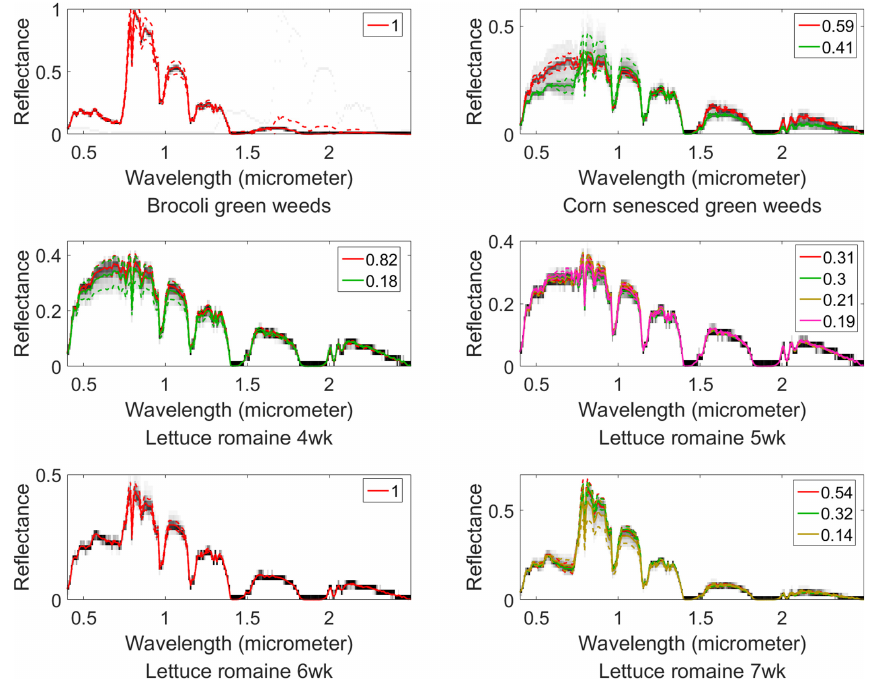
Figure 12. Estimated GMM-SS-LRR in the wavelength–reflectance space for the Salinas-A dataset. The background gray image and the curves have the same meaning as in Figure